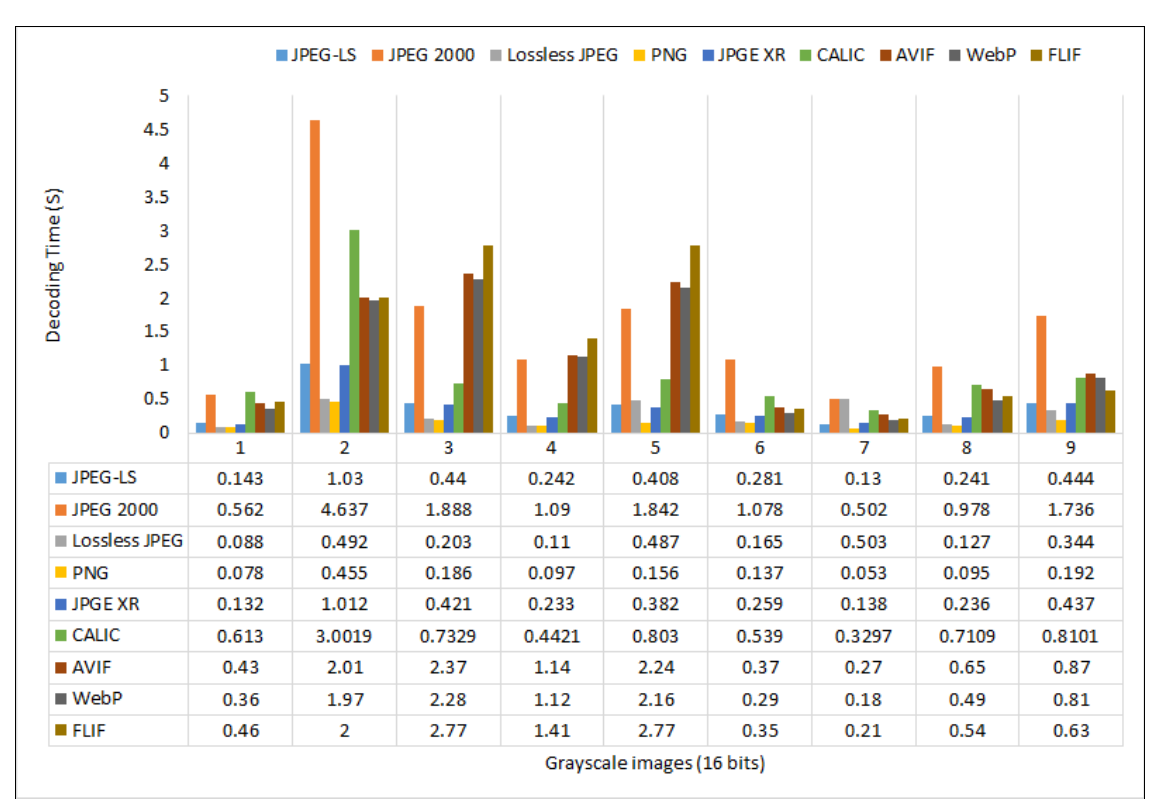
Figure 22. Comparison of decoding times for 16-bit greyscale images. Table 7. Comparison of compression ratios for 16-bit greyscale images.